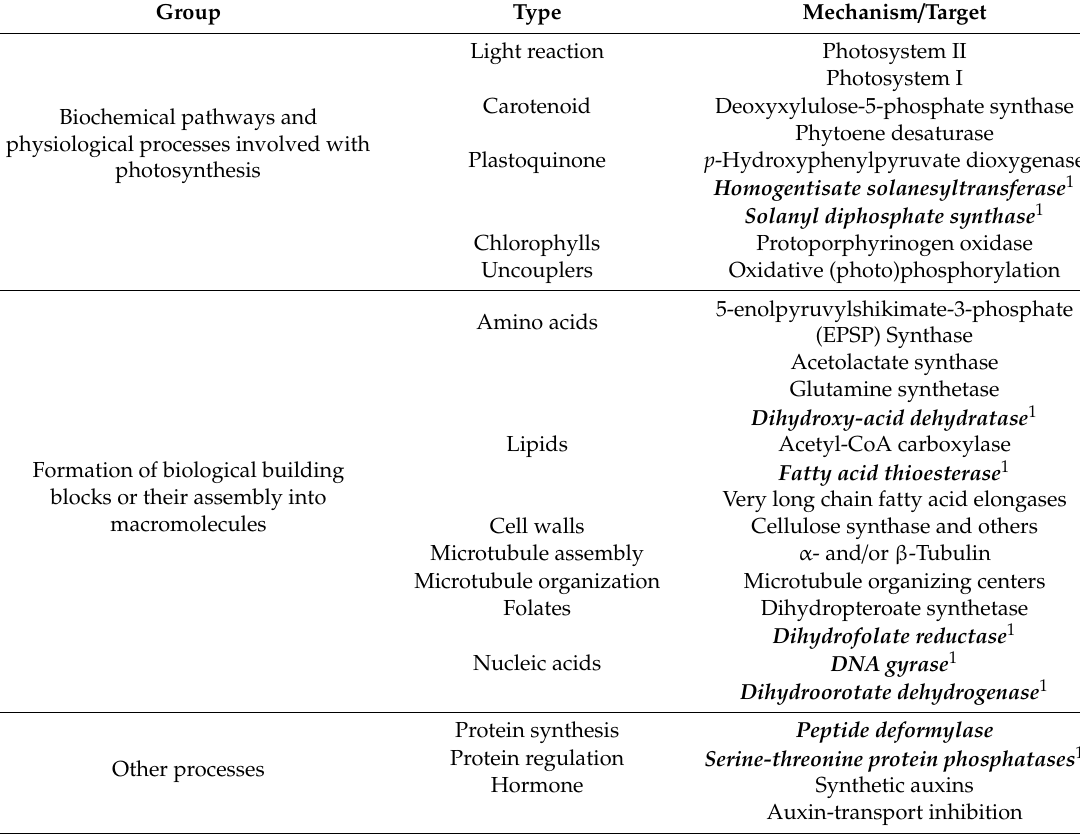
Table 1. Classification of mechanisms of action for current and potential new commercial herbicides discussed in this